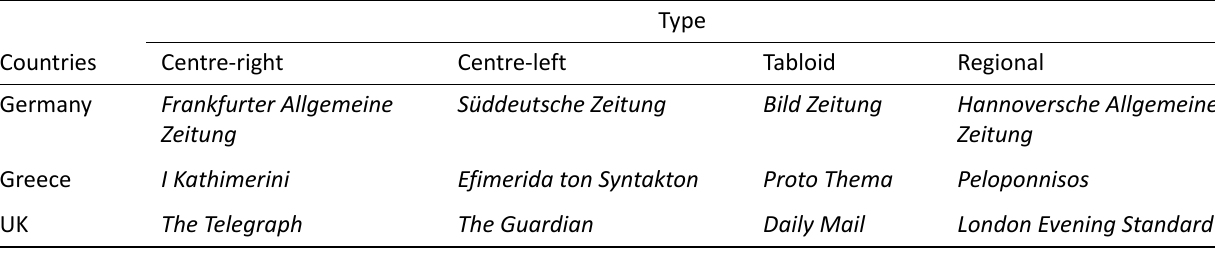
Table 1. The media outlets of the